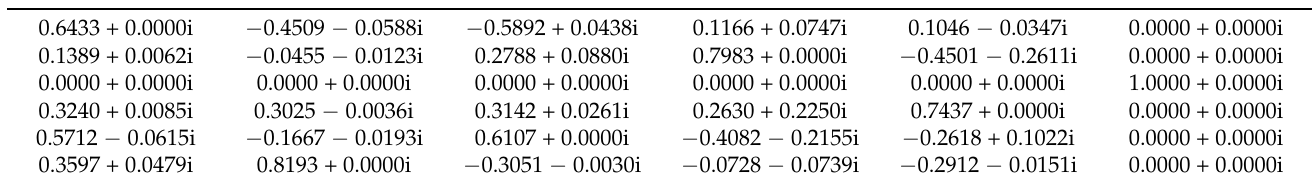
Table 5. Right eigenvector (V = ˆ I Lnew ).